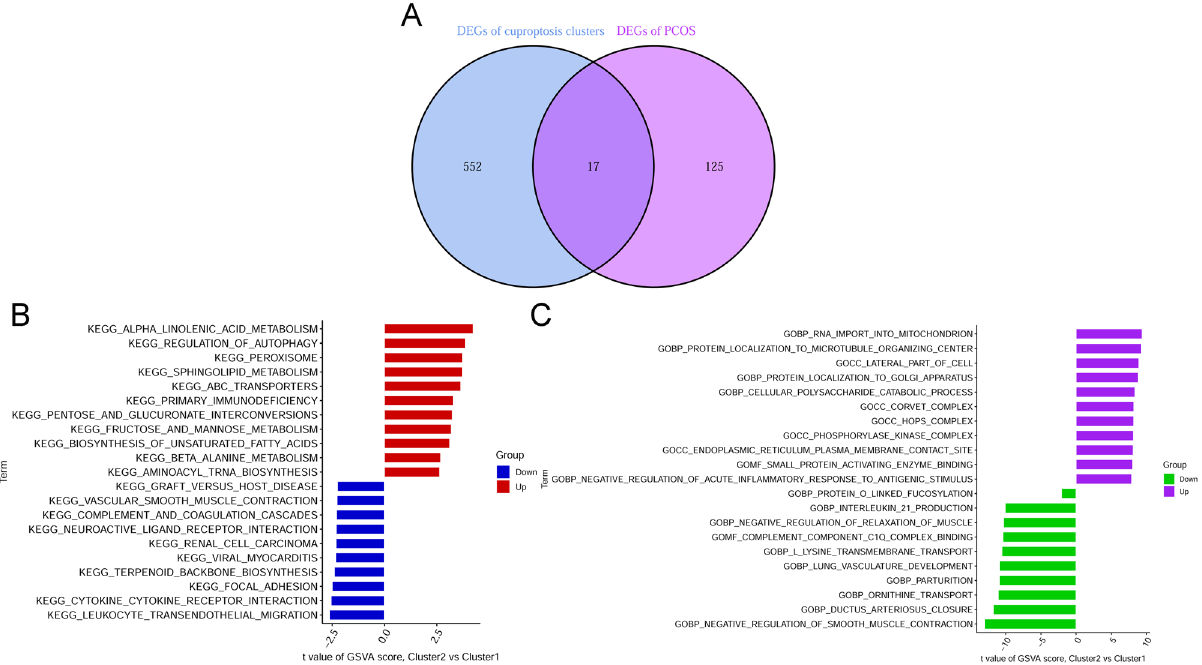
Figure 7. Identification of cluster-specific DEGs and biological characteristics between two cuproptosis clusters. ( A ) The intersections between genes related to module in cuproptosis clusters and genes related to module in GSE5090, GSE43264, GSE98421, and GSE124226 datasets. ( B ) Differences in hallmark pathway activities between Cluster1 and Cluster2 samples were sorted by t-value of GSVA method. ( C ) Differences in biological functions between Cluster1 and Cluster2 samples were sorted by t-value of GSVA